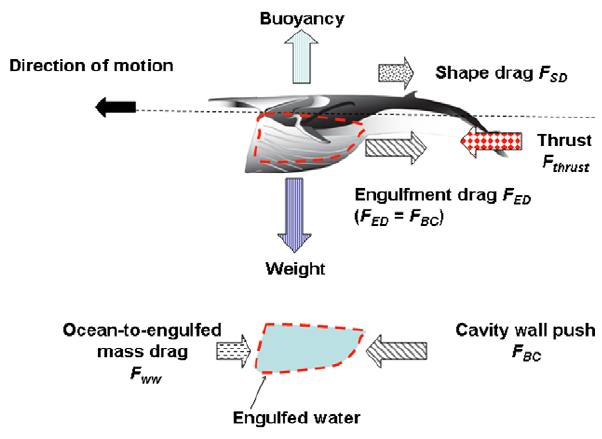
Figure 2. Forces acting on the whale body and engulfed mass.